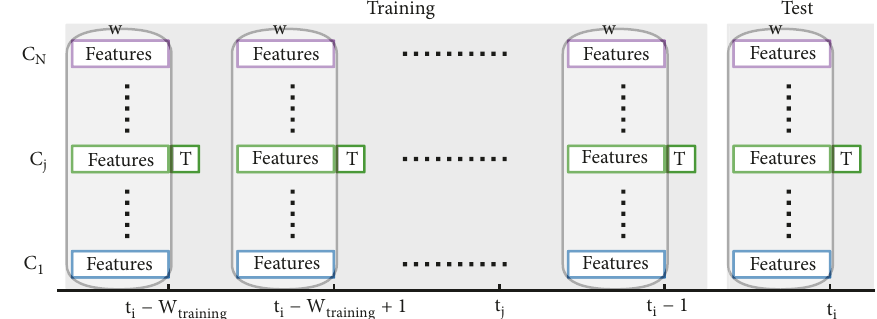
Figure 4: Schematic description of Method 2. The training set is composed of features and target (T) pairs, where features are various characteristicsof all currencies, computed across the 𝑤 days preceding time 𝑡 𝑗 and the target 𝑇 is the price of 𝑐 𝑖 at 𝑡 𝑗 . The features-target pairs include a single currency 𝑐 𝑖 , for all values of 𝑡 𝑗 included between 𝑡 𝑖 − 𝑊 𝑡𝑟𝑎𝑖𝑛𝑖𝑛𝑔 and 𝑡 𝑖 − 1 . The test set contains a single features-target pair: the characteristics of all currencies, computed across the 𝑤 days preceding time 𝑡 𝑖 and the price of 𝑐 𝑖 at 𝑡 𝑖